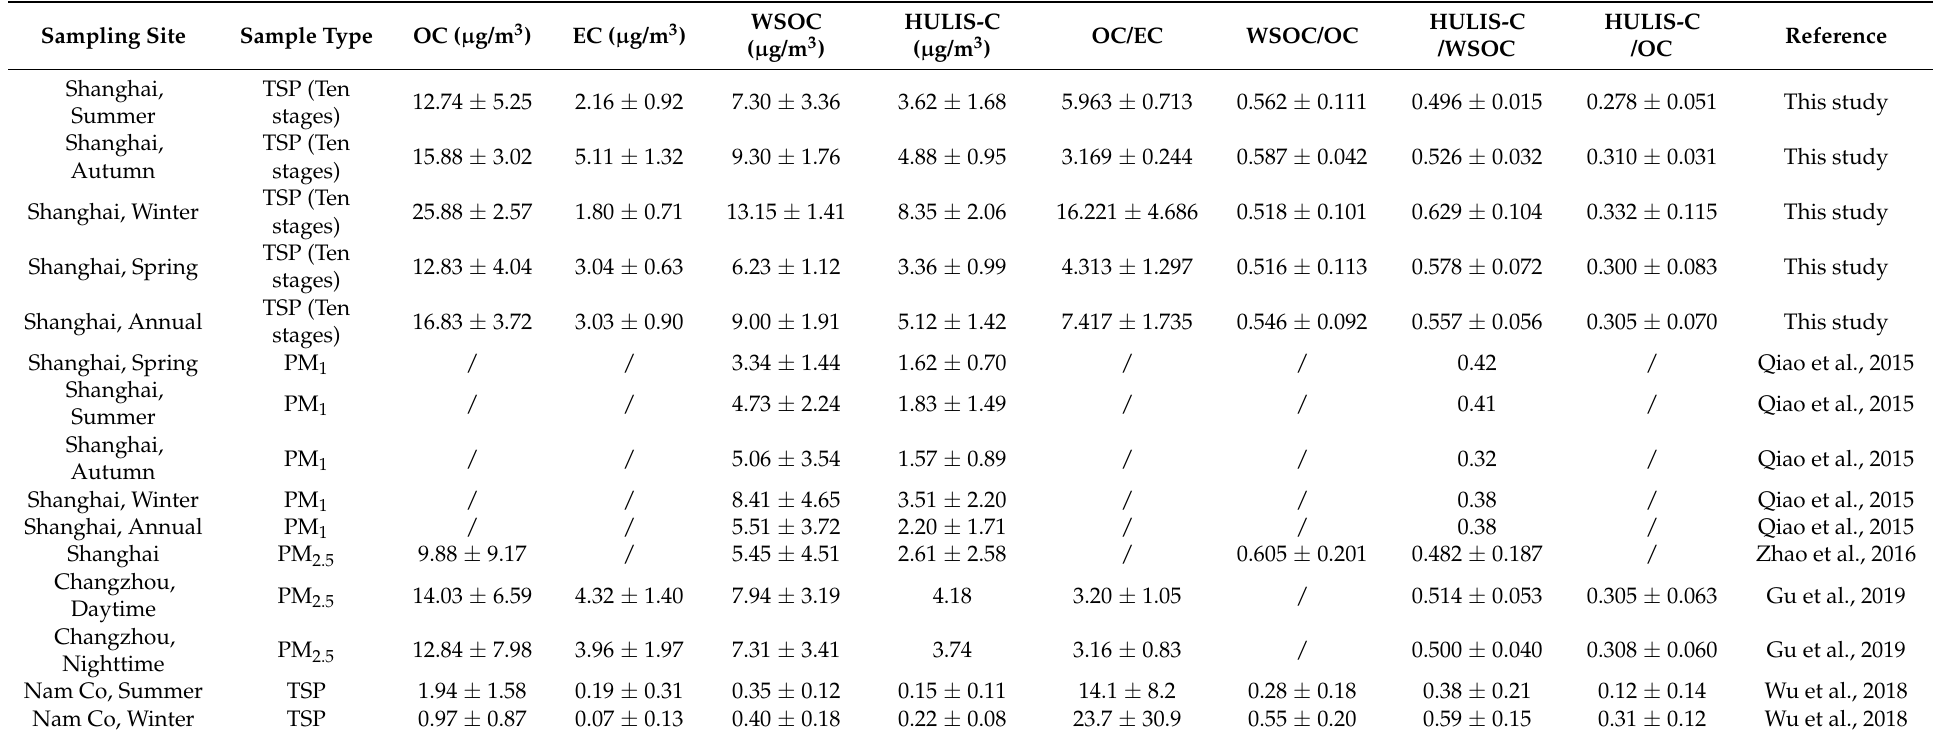
Table 1. Mass concentrations of OC, EC, WSOC and HULIS and their ratios in comparison to previous